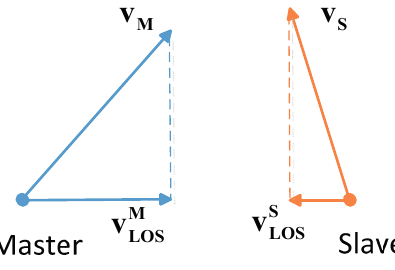
Figure 6. Diagrammatic sketch of LOS